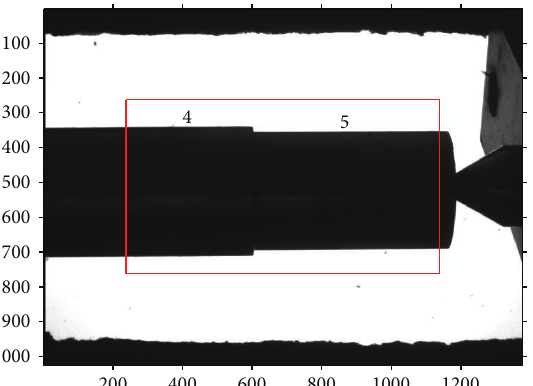
Figure 8: The imaging of four-segment shaft.